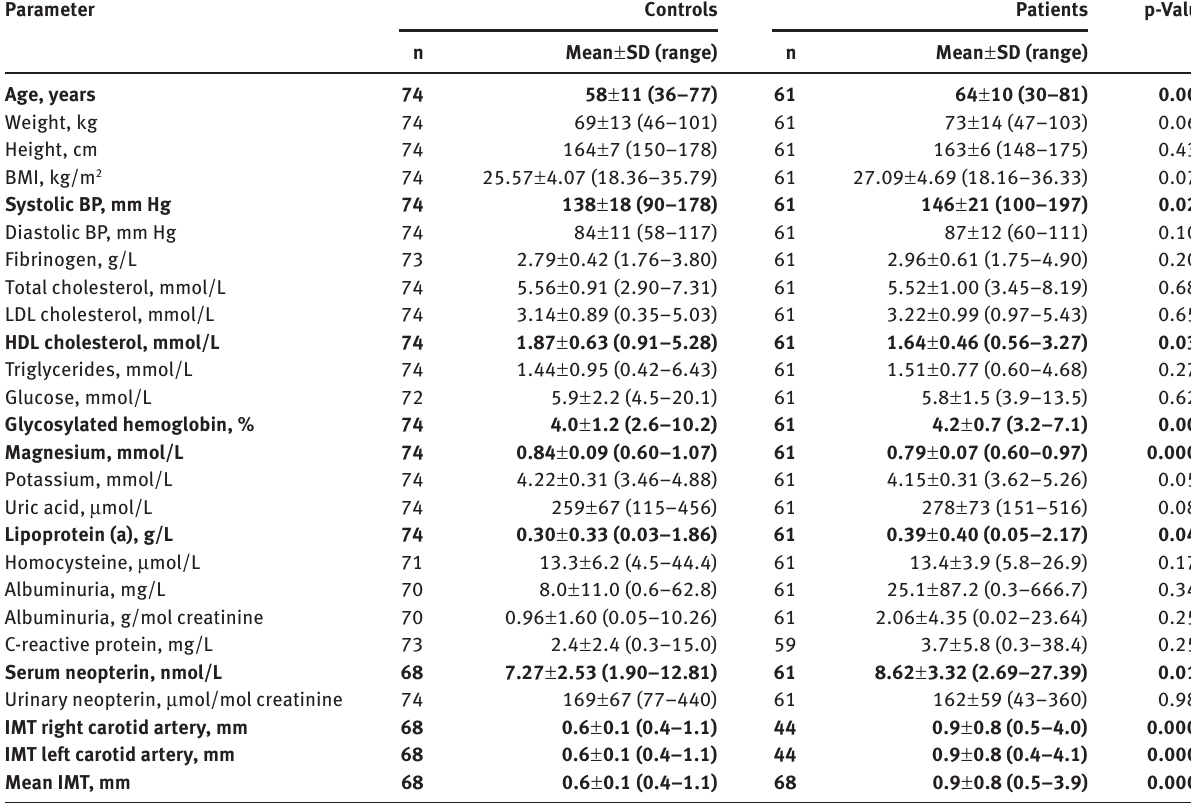
Table 2 Distribution of clinical and laboratory parameters in patients and controls.